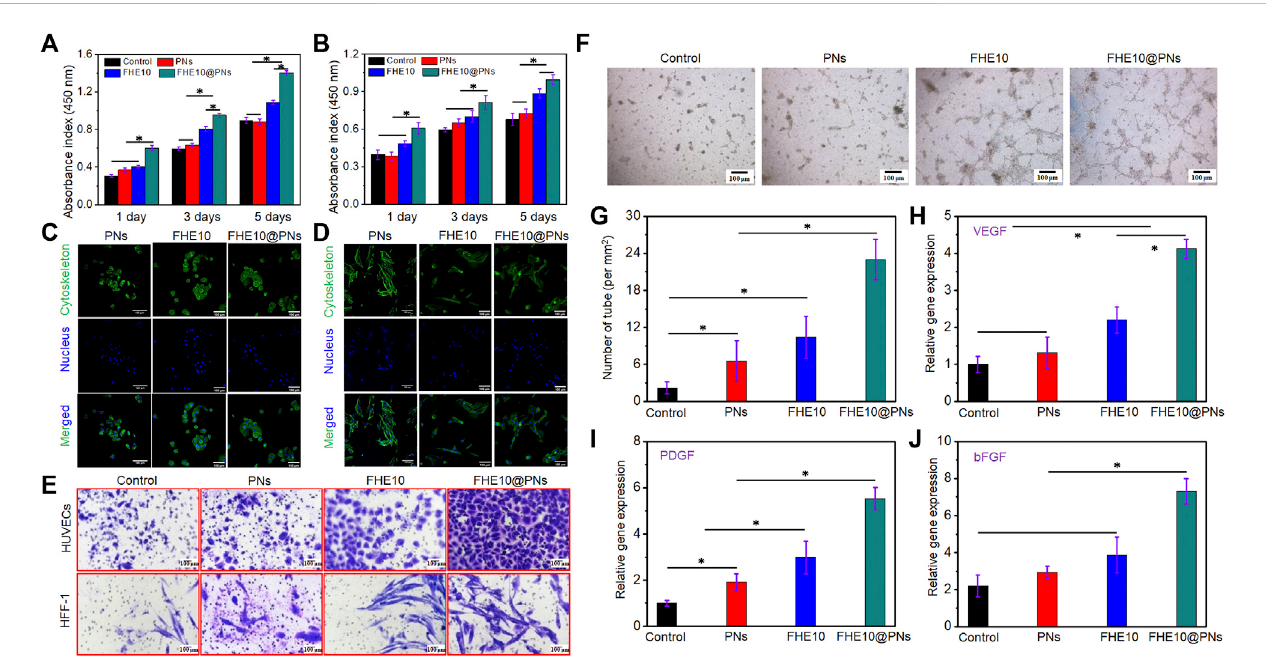
FIGURE 4 (A,B) CCK-8 assay indicated that proliferation of HUVECs and HFF-1 after culturing with PNs, FHE10, and FHE10@PNs, respectively; (C,D) DAPI (blue)/ FITC-phalloidin (green) staining assay of HUVECs and HFF-1 with PNs, FHE10, and FHE10@PNs after culturing, respec-tively; (E) Transwell assay showed that migration of HUVECs and HFF-1 were stained by crystal violet; (F) Tube formation assay; (G) Quantitative analysis of tube formation; (H – J) qRT-PCR analysis of VEGF, PDGF, and